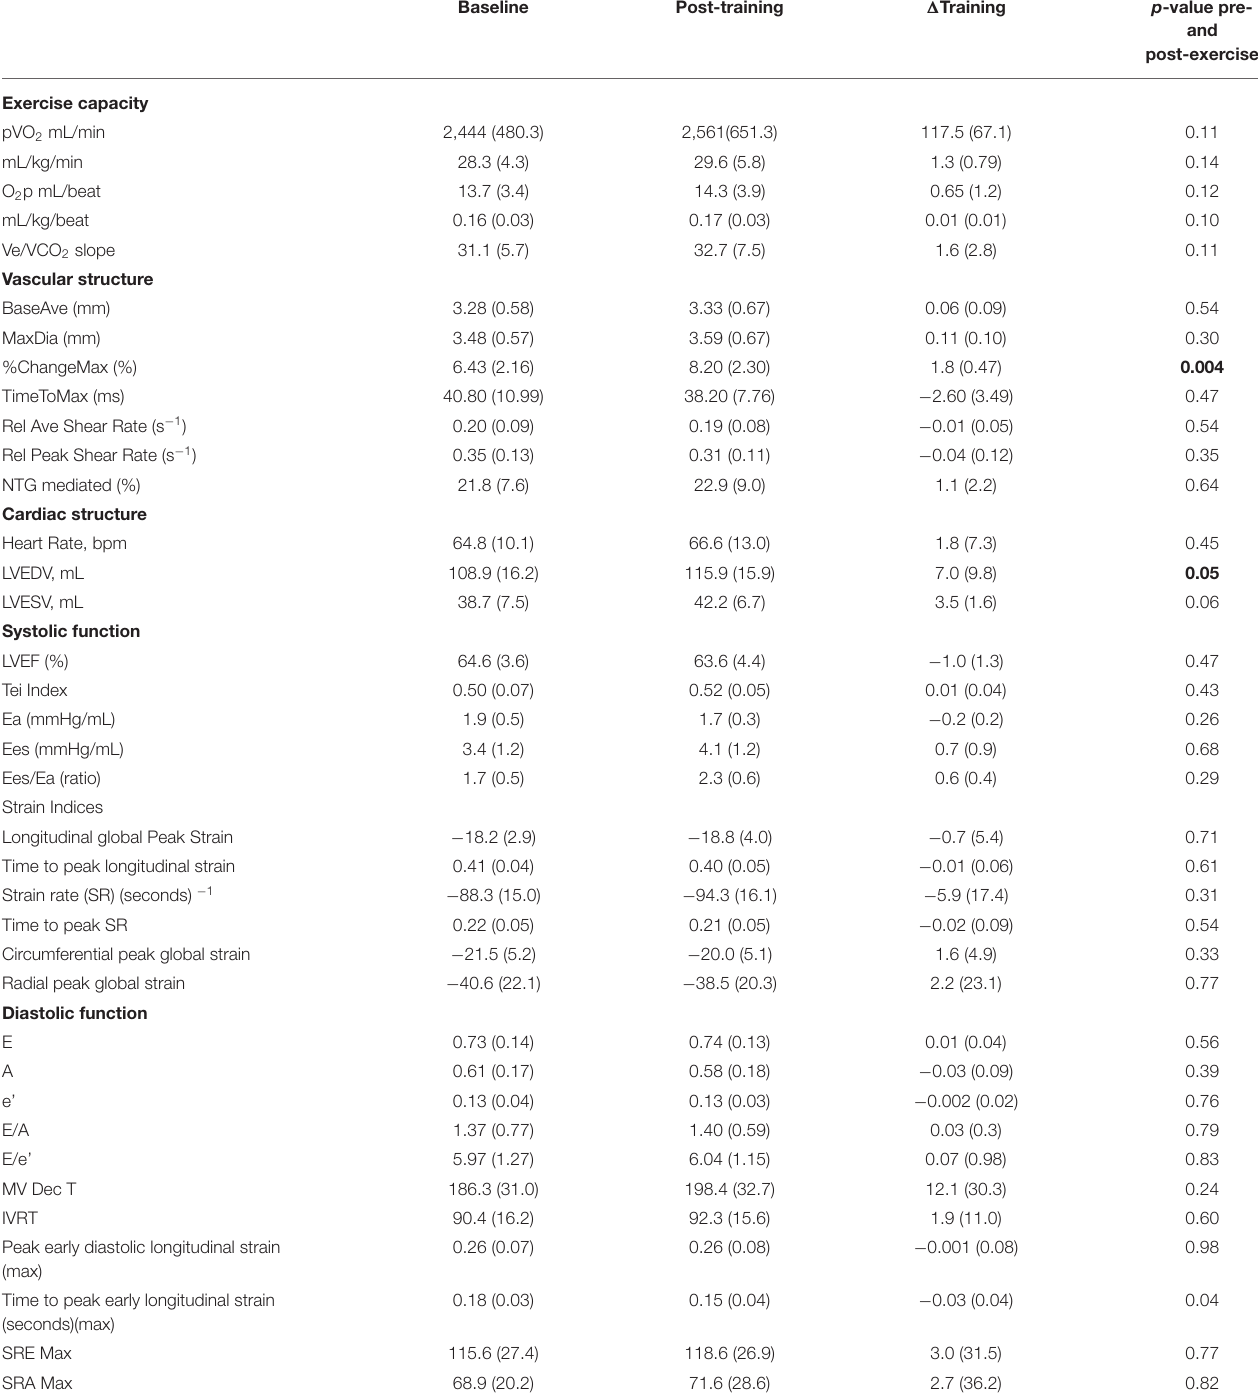
Baseline Post-training